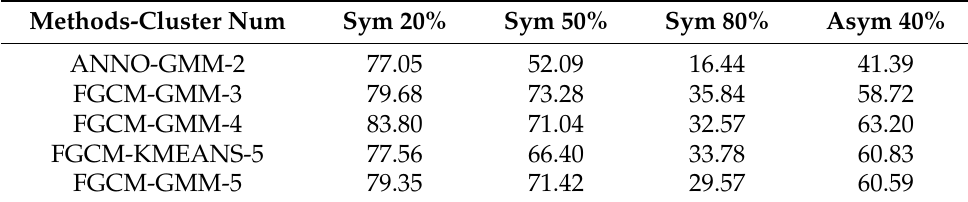
Table 8. Recall of obtained labels using different clustering methods and cluster numbers on CIFAR- 10 with different type and ratios of noise. ANNO-GMM-2 denotes experiment that only uses the confidence of annotation label to divide samples into two